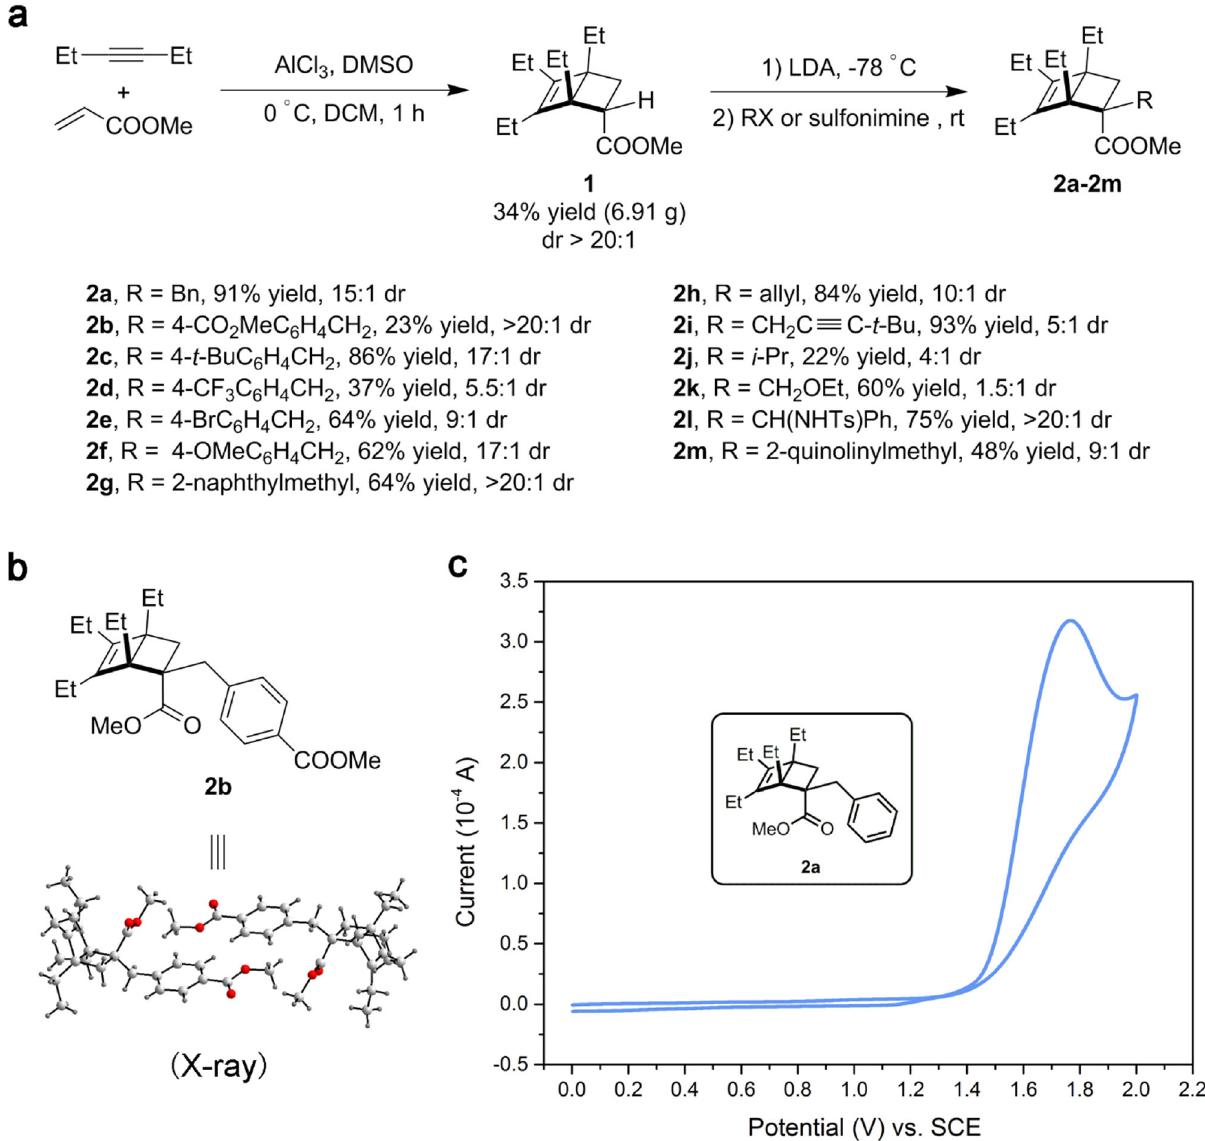
Fig. 2 Modular preparation of BCHs and characterizations. a Synthetic approach to alkylated BCHs 2a – 2m . b Determination of the relative stereochemistry of the major diastereomer of 2b . c Cyclic voltammogram of 2a in MeCN with 0.10 M Bu 4 NPF 6 . The scan rate was 0.10